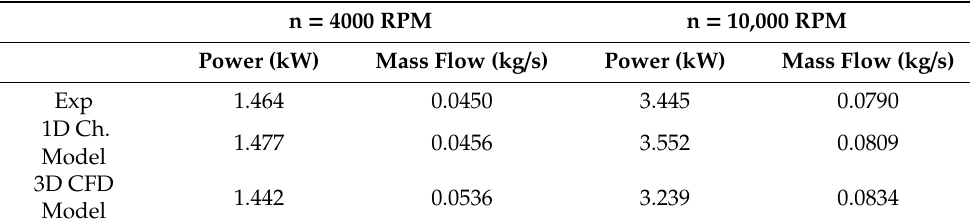
Figure 6. Measured and calculated indicated power and mass flow as a function of rotational speed (Pi = 2 bar and Ti = 75 °C). Table 2. Indicated power and mass flow rates for 4000 and 10,000 RPM.